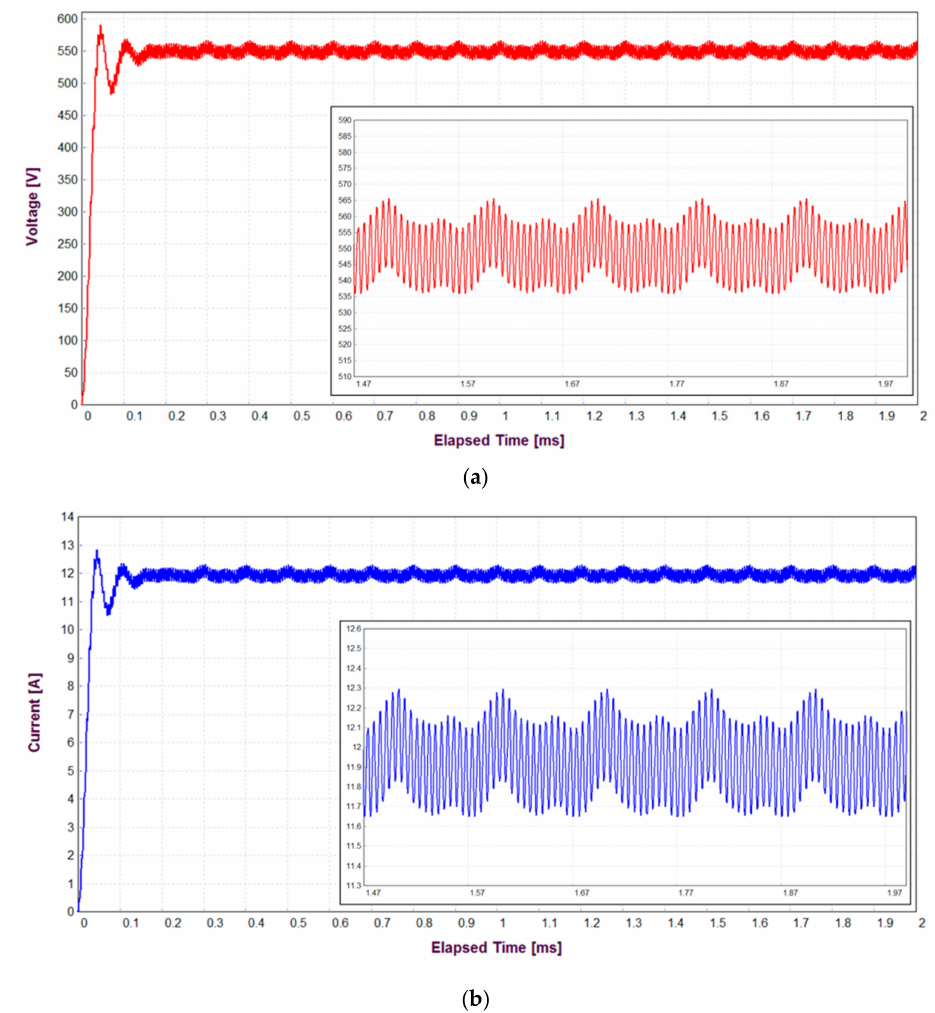
Figure 14. Simulation results: ( a ) load voltage waveform, and ( b ) load current waveform.